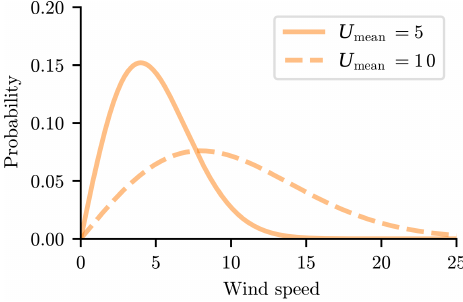
Figure 7. Example Weibull distributions for two different average wind speeds. Each wind direction is associated with an average wind speed (shown in Fig. 6), which is used for the value U mean